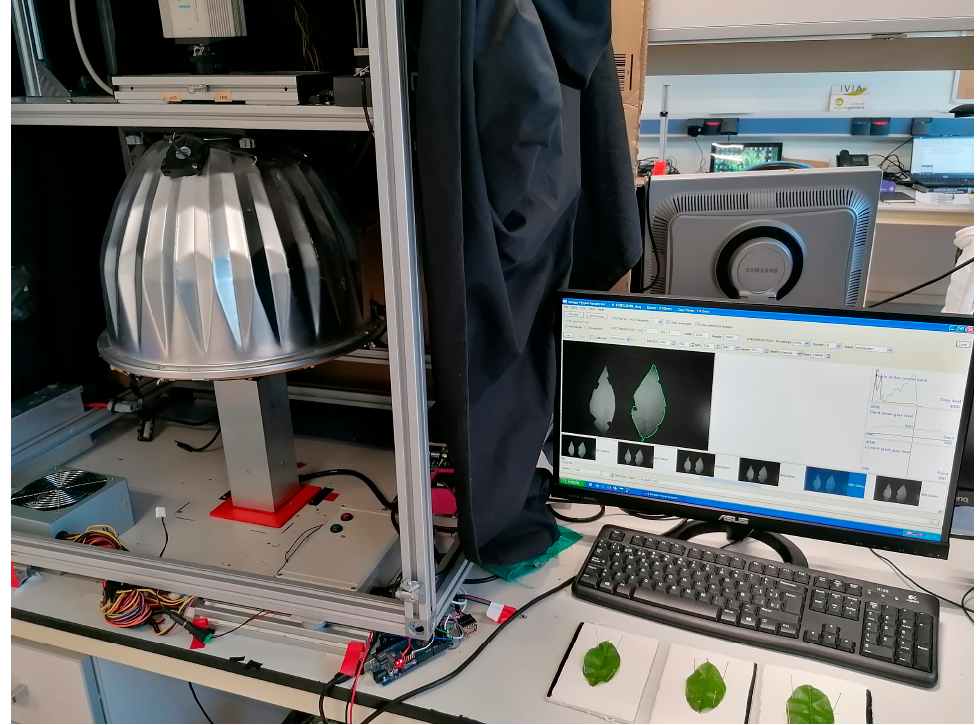
Figure 1. Acquisition of the hyperspectral imaging of the leaves. Images were corrected using white and dark references. Dark was captured by switching off the lamps and covering the lens with a cap to prevent light from infiltrating the camera. The correction was performed using Equation (1):